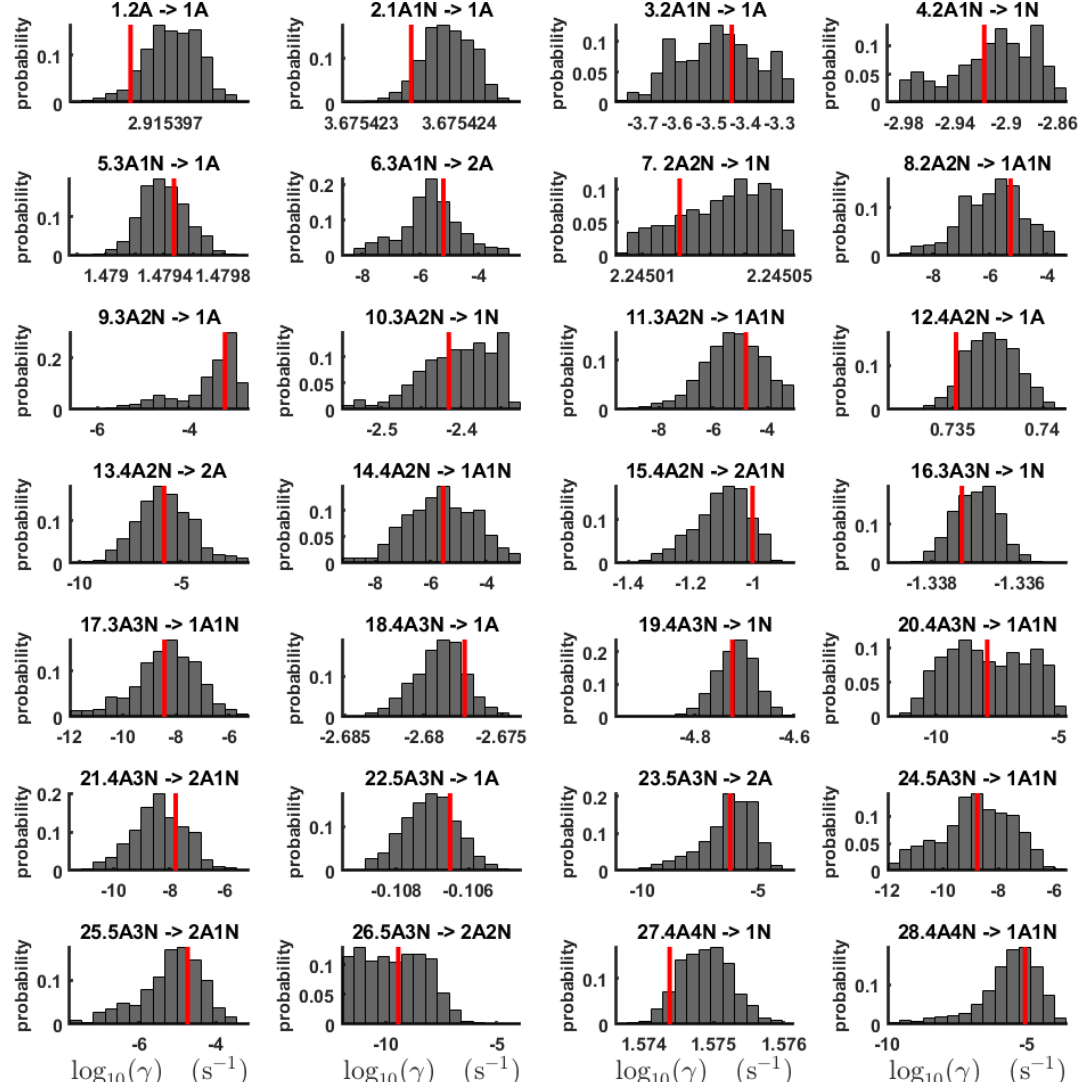
Figure 6. One-dimensional marginal posterior distributions (for parameter indexes ranging from 1 to 28) of the base 10 logarithm of the evaporation rates (units given in s − 1 ) determined from time-dependent measurements of the cluster concentrations with time resolution comprising 1.5min at the temperature 278K. Red lines denote the baseline values from Olenius et al. (2013b) used to generate the synthetic data. The notation xAyN corresponds to a cluster with x sulfuric acid and y ammonia